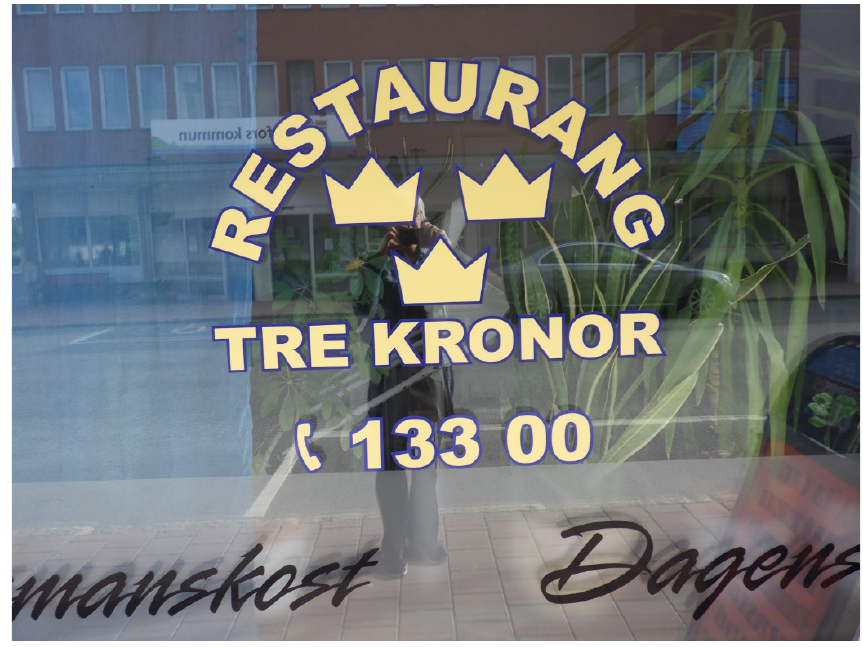
Figure 8. Name of Restaurant .